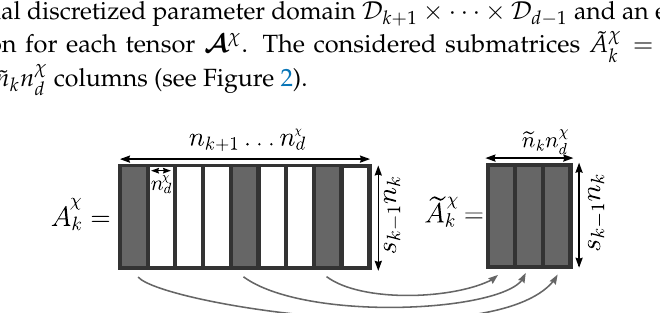
used to construct the POD reduced basis. In the illustration, k